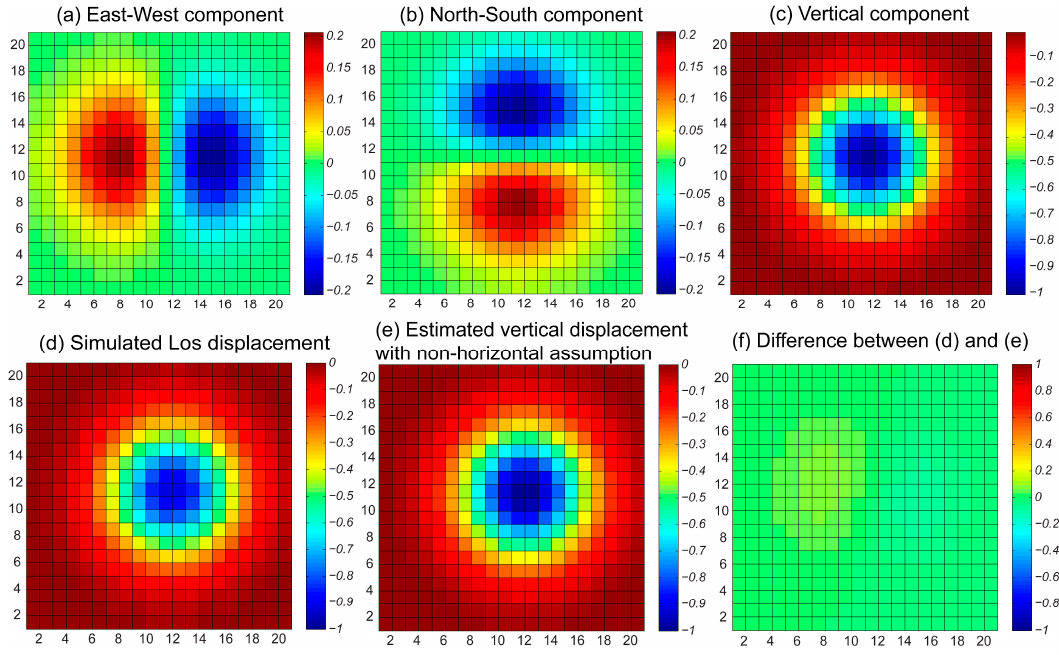
Figure A2. Simulated three-dimensional (3D) displacement components in ( a ) the east − west directions; ( b ) north − south directions; and ( c ) vertical directions; ( d ) Simulated LOS displacement; ( e ) estimated vertical displacement with non-horizontal assumption; ( f ) the vertical residue estimated by difference between ( d ) simulated LOS displacement and ( e ) with non-horizontal assumption.